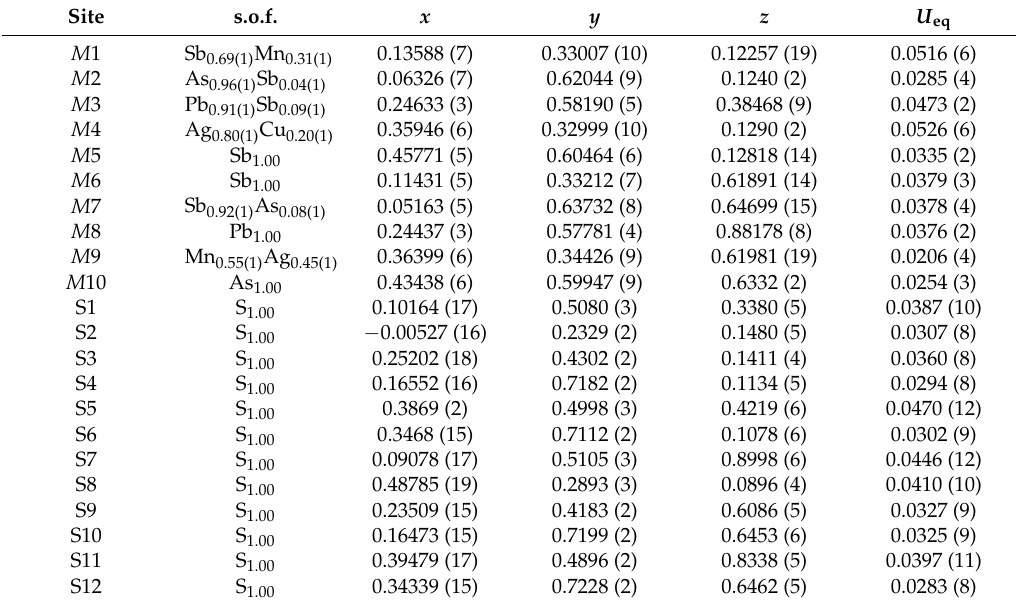
Table 3. Atomic coordinates, site occupancies, and equivalent isotropic displacement parameters (in Å 2 ) for